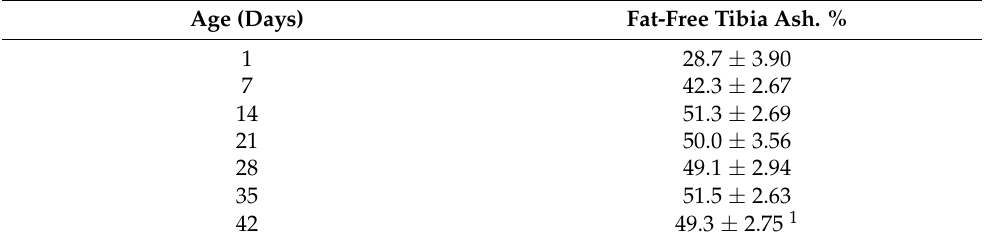
Table 4. Influence of age on the fat-free tibia ash content (% tibia) of broilers fed maize–soybean diets containing recommended concentrations of calcium and non-phytate phosphorus (Massey University, unpublished